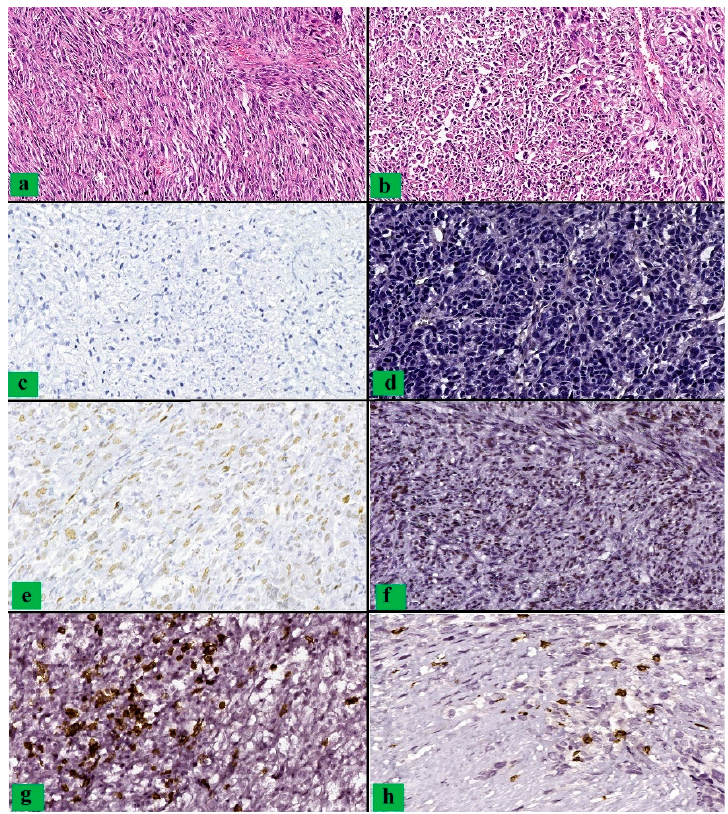
Figure 1. Leiomyosarcoma: ( a , b ) microscopic aspects showing a proliferation of malignant smooth muscle fibers with increased density and the presence of atypical mitoses (HE, ob 200×); ( c , d ) p53 null-type (ob 200×); ( e , f ) p53 overexpressed (ob 200×); ( g , h ) CD8 positive T cells (ob 200×).